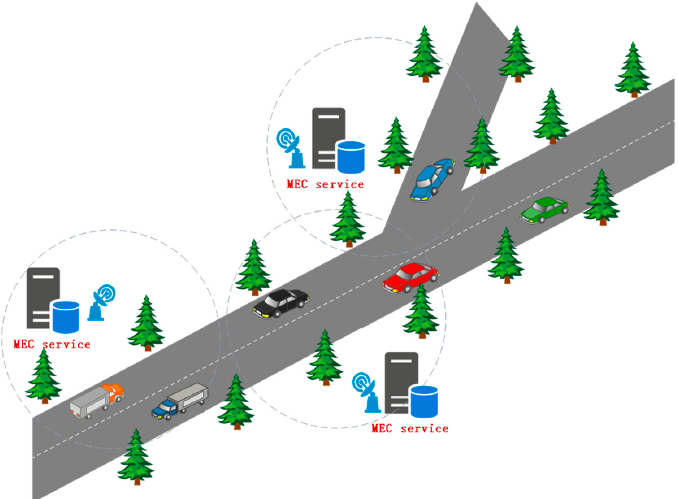
Figure 1. An illustration of the system model.